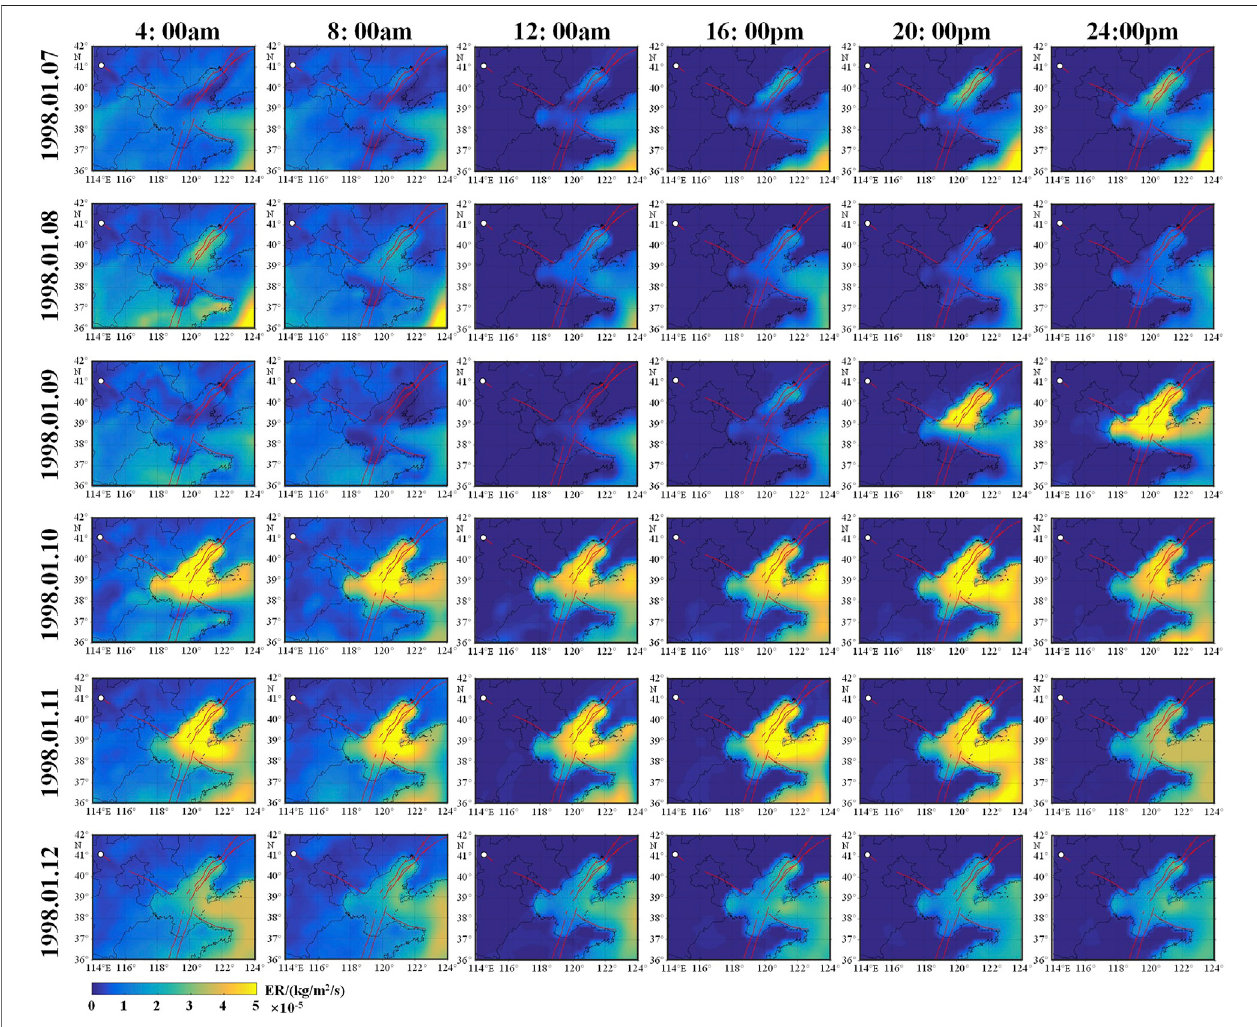
FIGURE 5 | The change of ER pattern over Bohai Sea from 7 to 12 January